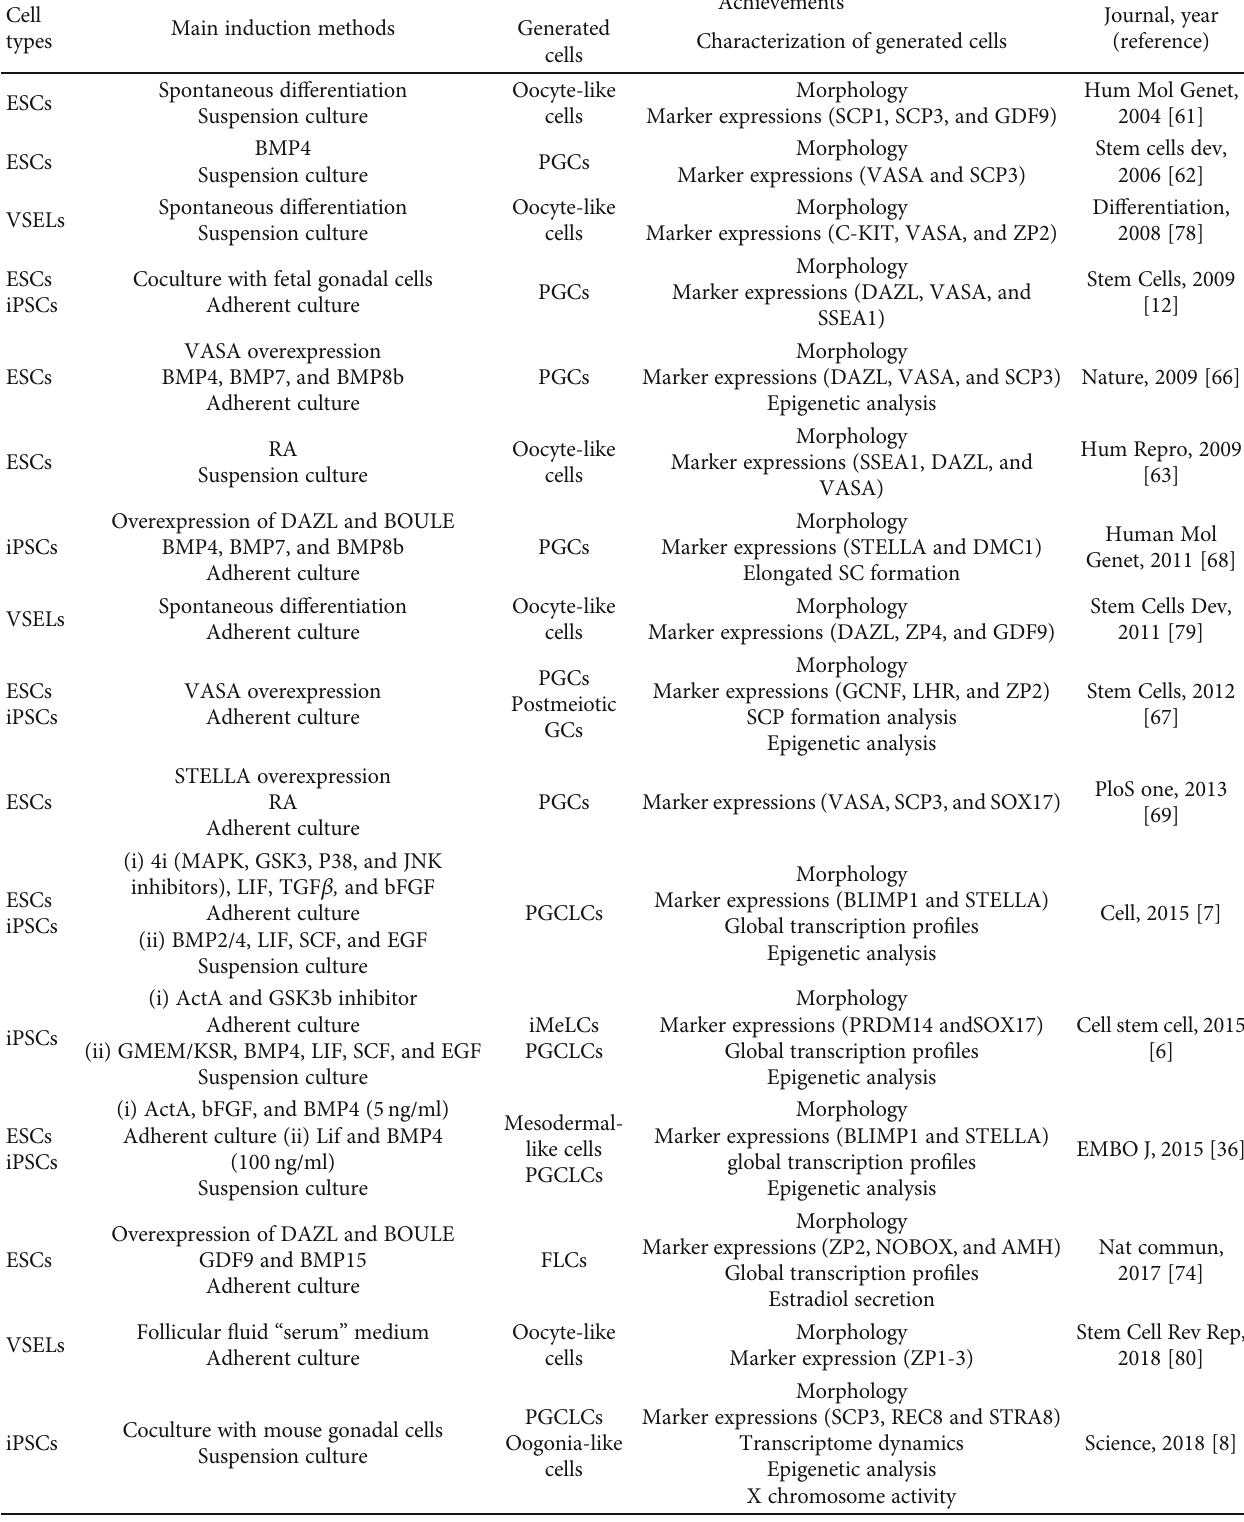
Table 2: Human female GCs di ff erentiation from PSCs in